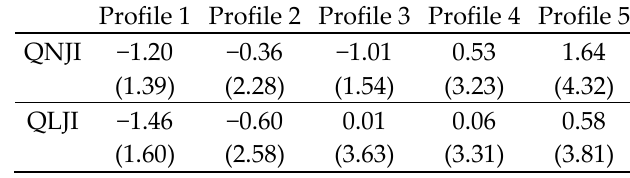
Figure 2. Graphical representation of the profiles of Sample 2. Scale scores between brackets. Q(N/L)JI = Felt Quantitative/Qualitative Job Insecurity.